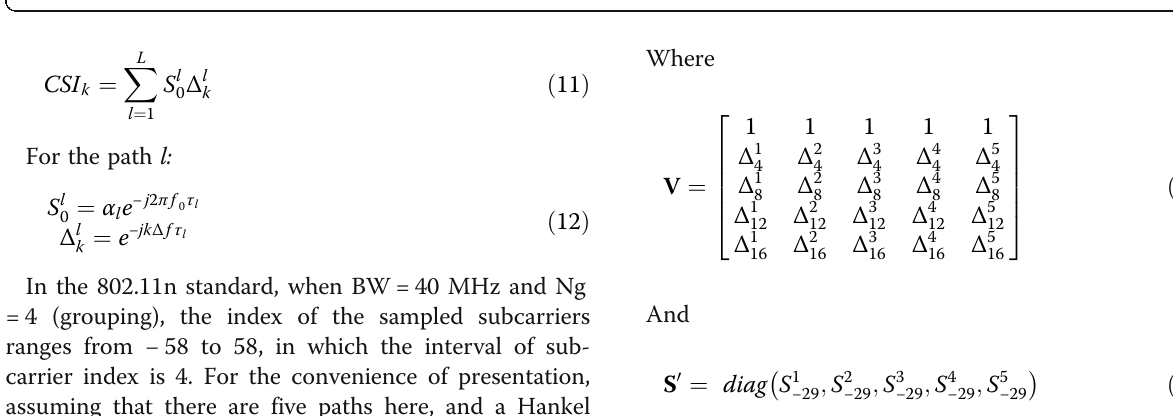
Fig. 4 a Raw phase vs. calibrated phase. The orange line in is the raw phase value of each packet and the blue line is presented as calibrated phase after linear transformation algorithm. b Calibrated phase at three different locations. Red, blue, and yellow line illustrate the calibrated phase of subcarriers at different locations,